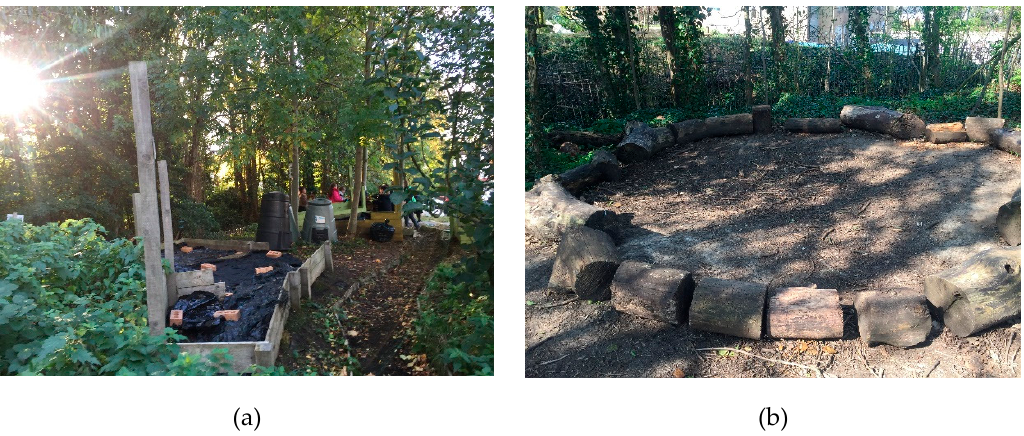
Figure 2. (a) The mound area with raised beds and the compost bins, (b) An outdoor seating area next to the